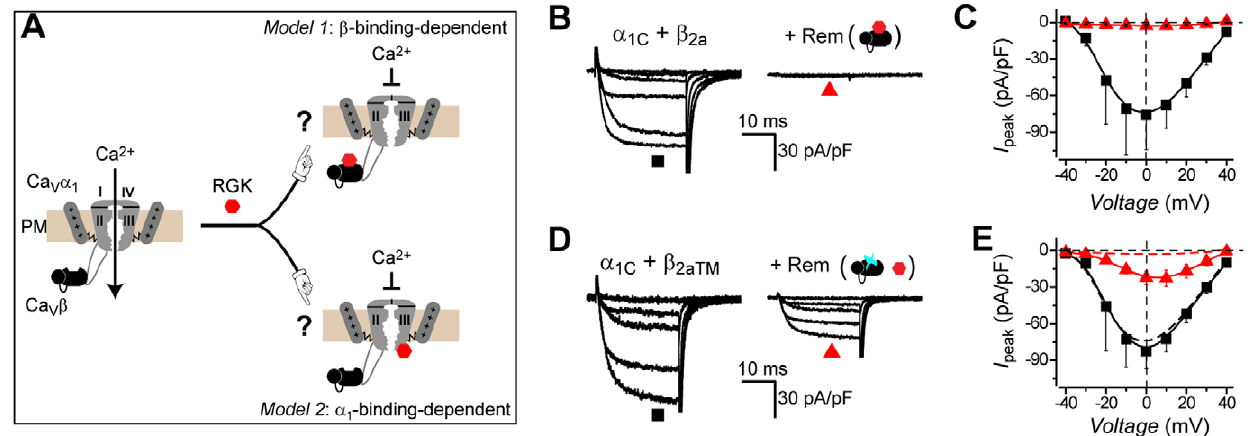
Figure 1. Rem inhibits Ca V 1.2 channels using both b -binding-dependent and independent mechanisms. (A) Alternative models for Rem functional interaction with Ca V 1.2 channel complex. (B) Exemplar Ba 2 + currents from HEK 293 cells expressing wild-type Ca V 1.2 ( a 1C + b 2a ) in the absence ( left ) or presence ( right ) of Rem. (C) Population current density ( I peak ) vs. voltage relationships for wild-type Ca V 1.2 channels in the absence ( & , n =6 for each point) or presence (red m , n =5 for each point) of Rem. Data are means 6 S.E.M. (D, E) Data for mutant Ca V 1.2 channels ( a 1C + b 2aTM ) in the absence ( & , n =8 for each point) or presence (red m , n =10 for each point) of Rem. Same format as B, C. In E , data from wild-type Ca V 1.2 channels are reproduced (dotted lines) to facilitate direct visual comparison.